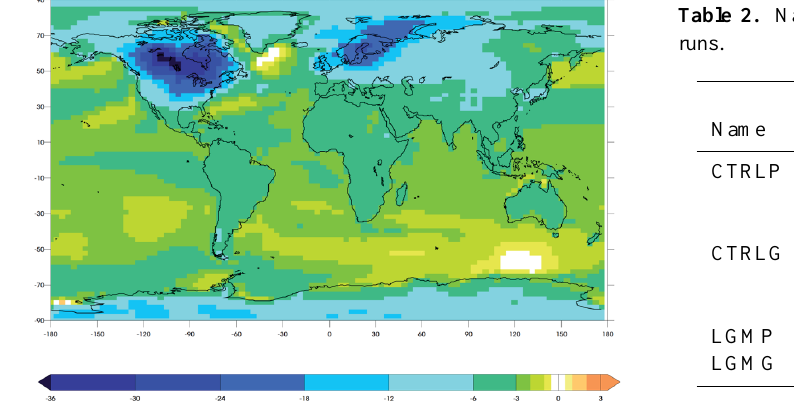
Table 2. Names and characteristics of the ORCHIDEE off-line runs.